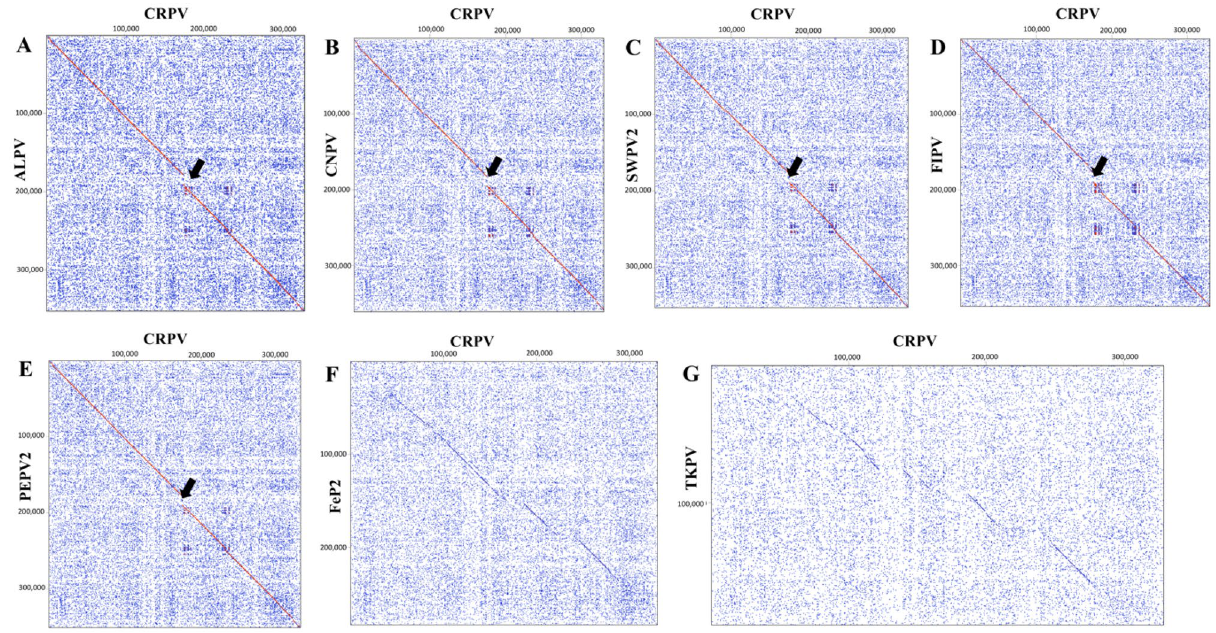
Figure 2. Dot plots of the CRPV genome (x-axis) versus other poxvirus genomes (y-axis). ( A ) CRPV versus ALPV, ( B ) CRPV versus CNPV, ( C ) CRPV versus SWPV2, ( D ) CRPV versus FIPV, ( E ) CRPV versus PEPV2, ( F ) CRPV versus FeP2 and ( G ) CRPV versus TKPV (refer to Table 3 for virus details and GenBank accession numbers). The Classic colour scheme was chosen in Geneious (version 22.1.1) for the dot plot lines according to the length of the match, from blue for short matches to red for matches over 100 bp long. Window size =